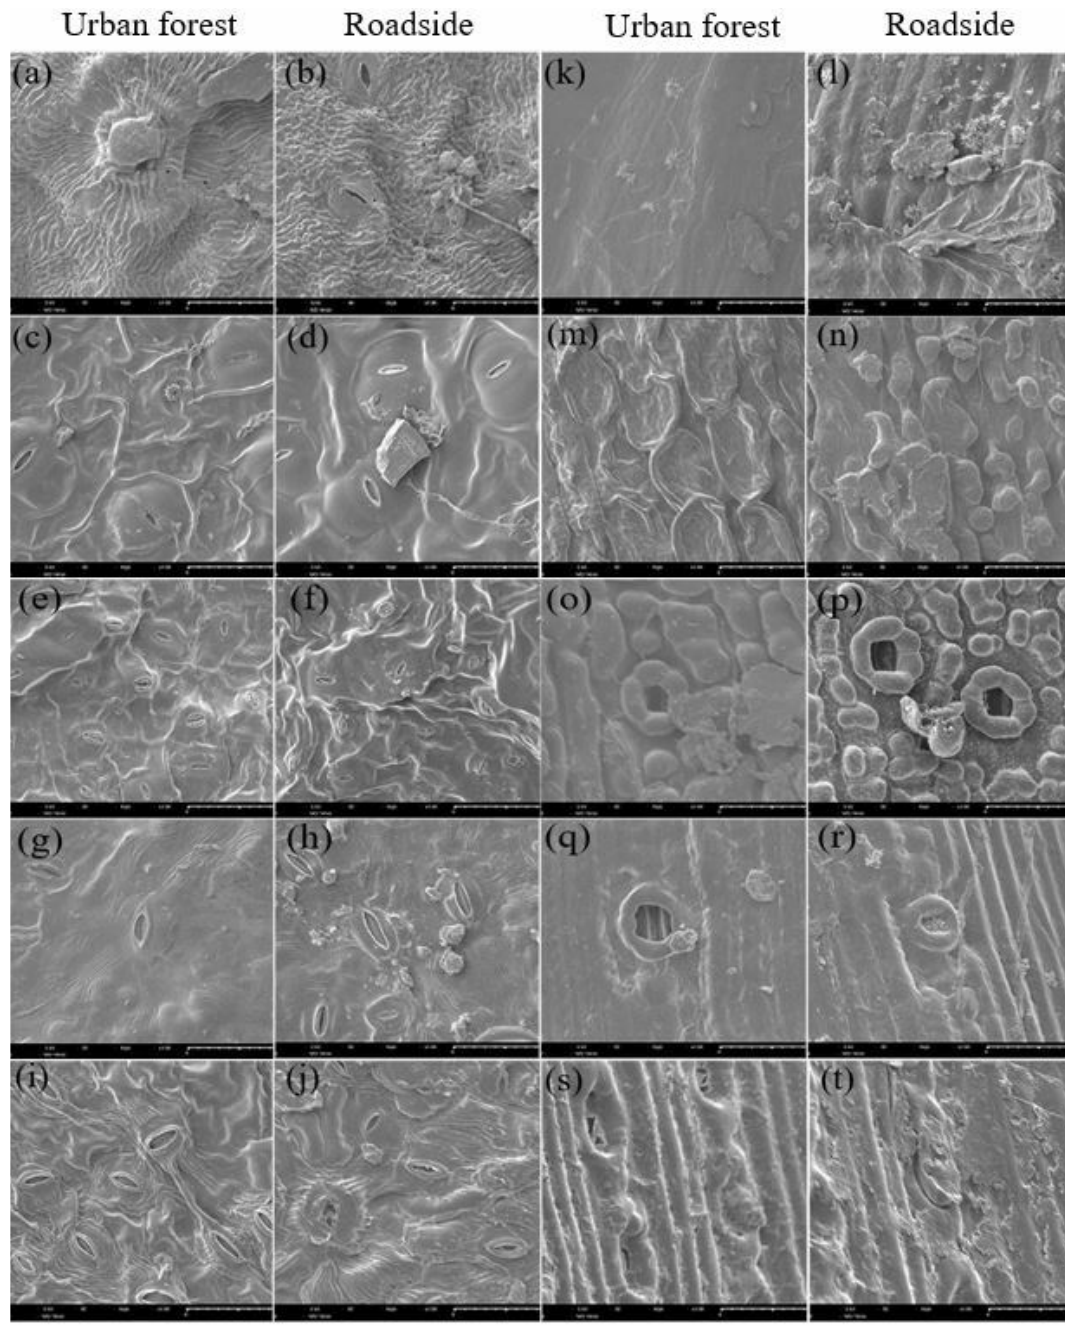
Figure 3. SEM (Scanning Electron Microscope) micrographs of 10 plant species ( a , b ) S. vulgaris , ( c , d ) M. denudata , ( e,f ) A. palmatum , ( g,h ) Z. serrata , ( i,j ) R. yedoense , ( k,l ) J. chinensis , ( m,n ) M. glyptosboises , ( o,p ) T. cuspidata , ( q,r ) P. densiflora , and ( s,t ) P. trobus in urban forest and roadside. The scale bar is 50 μ m.